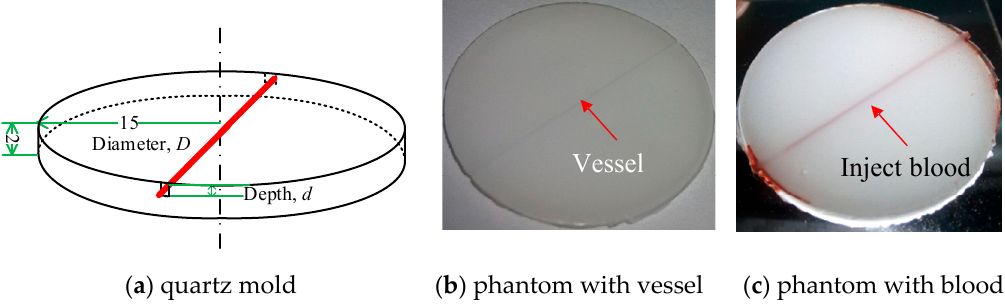
Figure 3. Construction of the skin phantom model.